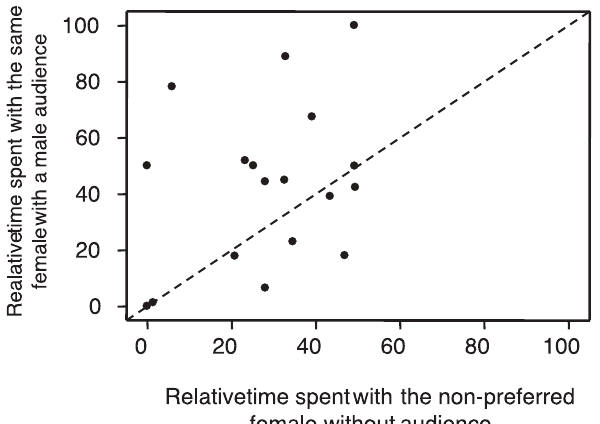
Figure 3. Influence of male audience on the time spent by the focal males with the female that was considered as the less attractive one in the control condition. Points above or below the dotted grey line represent respectively males that either decreased or increased their mating preference for the female that they considered the less attractive one, when there was no male